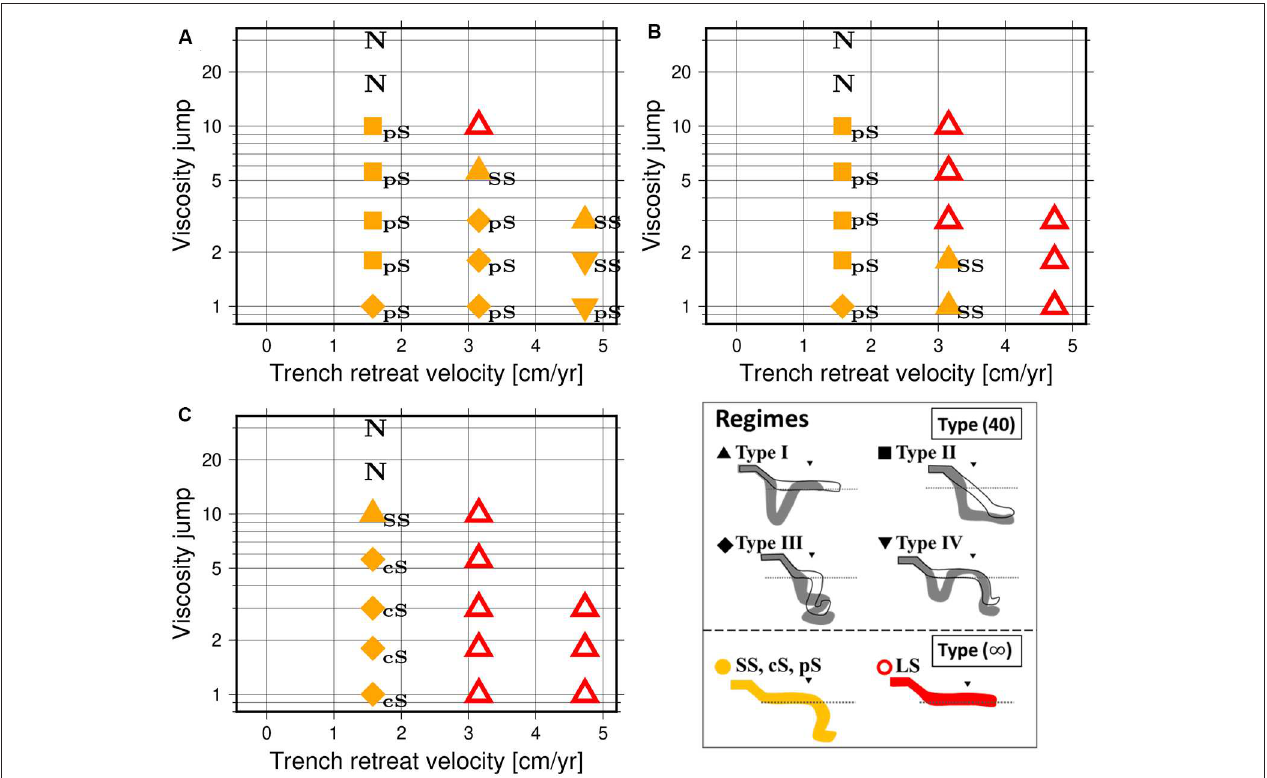
FIGURE 6 | Regime diagrams of the slab morphologies with sudden stop of trench retreat at around 40 My after the initiation of subduction as a function of trench retreat velocity v tr and viscosity jump r η for the cases of (A) γ 660 1 MPa/K, (B) γ 660 -2 MPa/K, and (C) γ 660 3 MPa/K. The symbols stand for the slab = − = = − morphologies of Type(40); triangles, squares, diamonds, and inverted triangles indicate Types I, II, III, and IV, respectively. The cases with “did not fall” are also indicated by the letter “N” in the figure. On the other hand, the colors of symbols stand for the slab morphologies of Type( ); red open symbols indicate LS, while ∞ yellow filled ones are other types whose Type( ) are indicated by small letters (“SS”, “pS,” and “cS”) attached to the symbols. In the schematic illustration of the ∞ regimes, slab morphologies before (black contour) and after (gray fill) changing v tr for Type I, II, III, and IV are shown. The black triangles and the dashed lines indicate the initial trench location and the 660 km discontinuity,